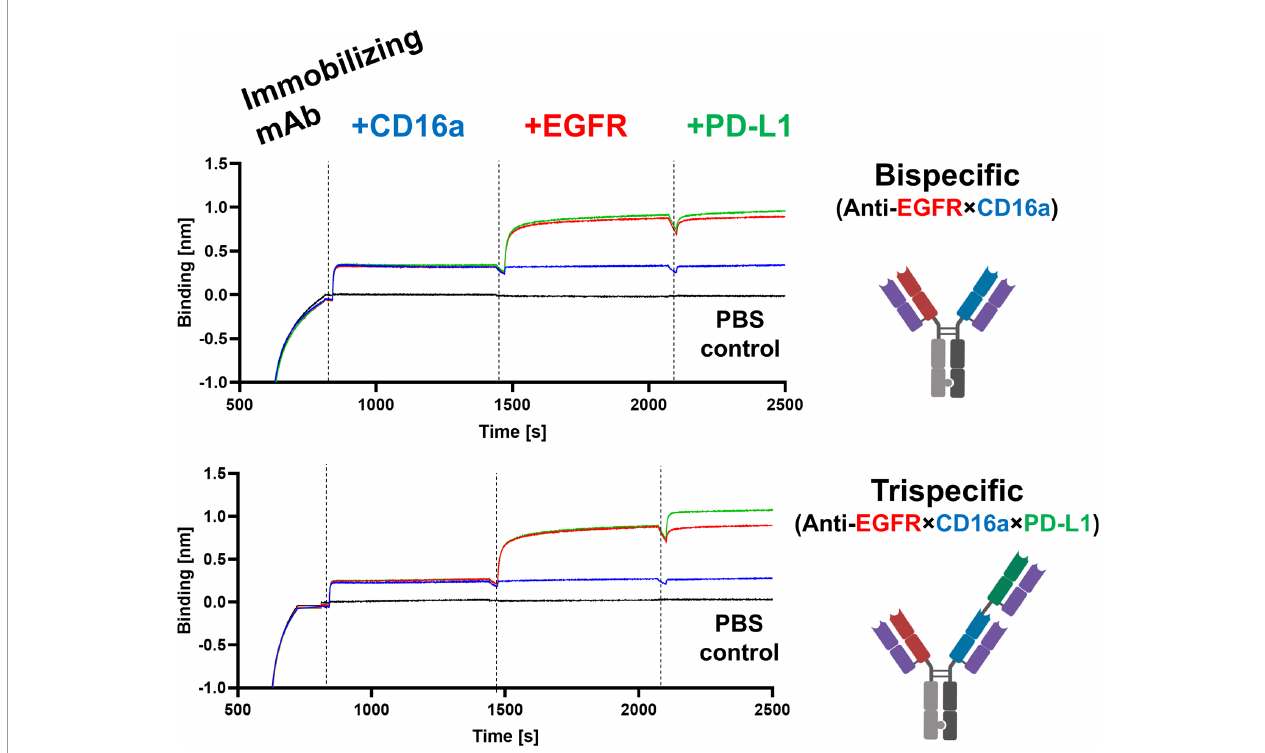
FIGURE 5 | Characterization of bi- and trispeci fi c humanized antibodies. BLI-assisted simultaneous binding assay. The bi- or trispeci fi c antibodies were loaded onto biosensors, and antigens are added step-wise, revealing EGFR×CD16a bispeci fi c or EGFR×CD16a×PD-L1 trispeci fi c binding,